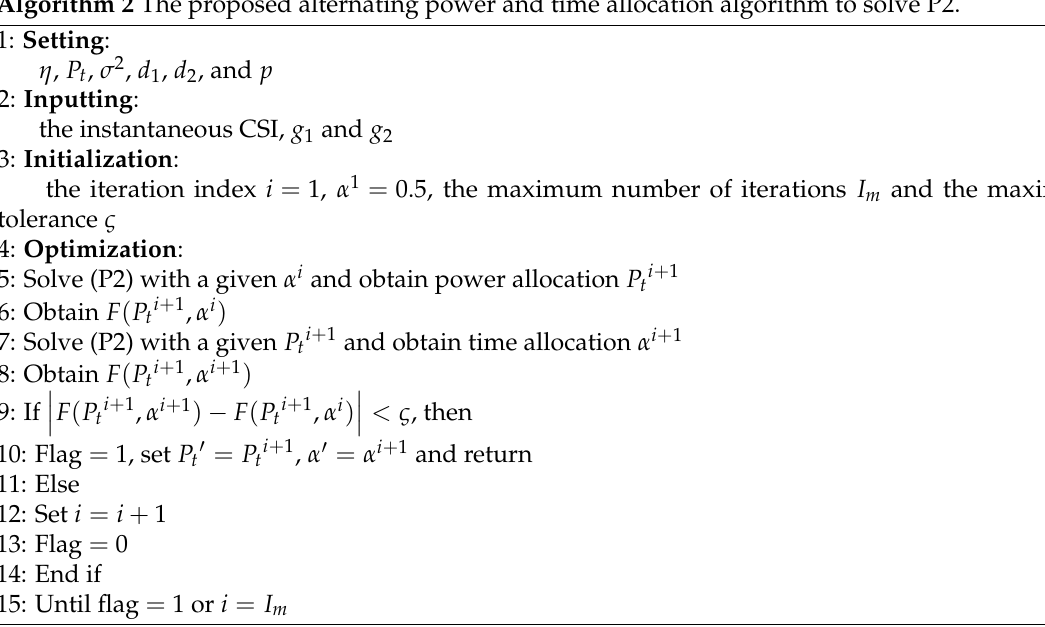
Algorithm 2 The proposed alternating power and time allocation algorithm to solve